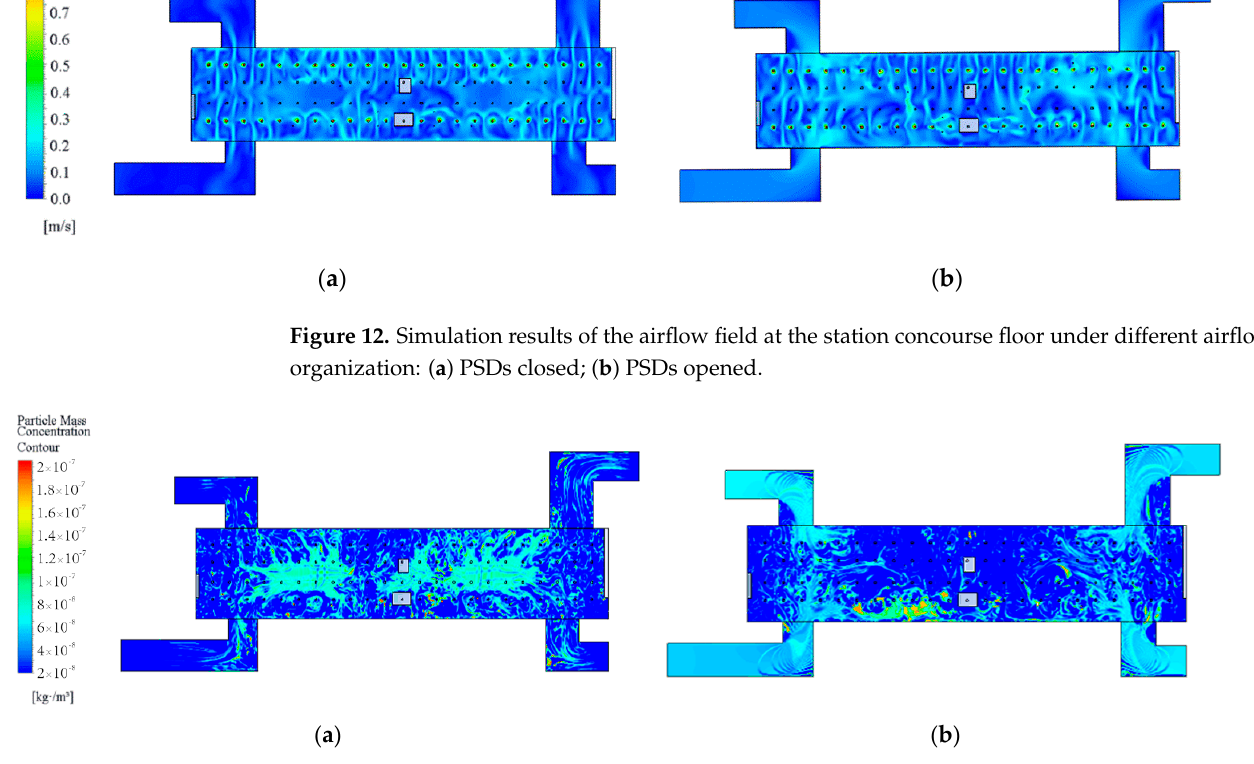
( b ) Figure 13. Simulation results of particle mass concentration contour at the station concourse floor under different airflow organization: ( a ) PSDs closed; ( b ) PSDs opened.